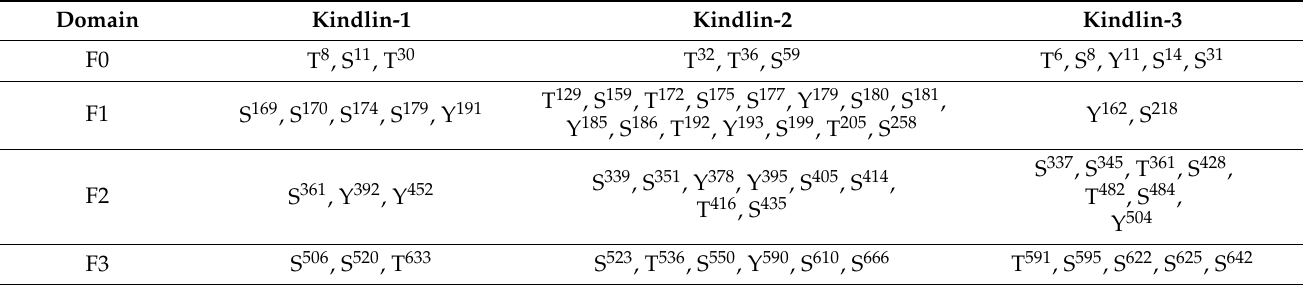
Table 1. Phosphorylated amino acids in kindlins: Compiled from: PhosphoSitePlus ® (www.phosphosite.org (accessed on 22 March